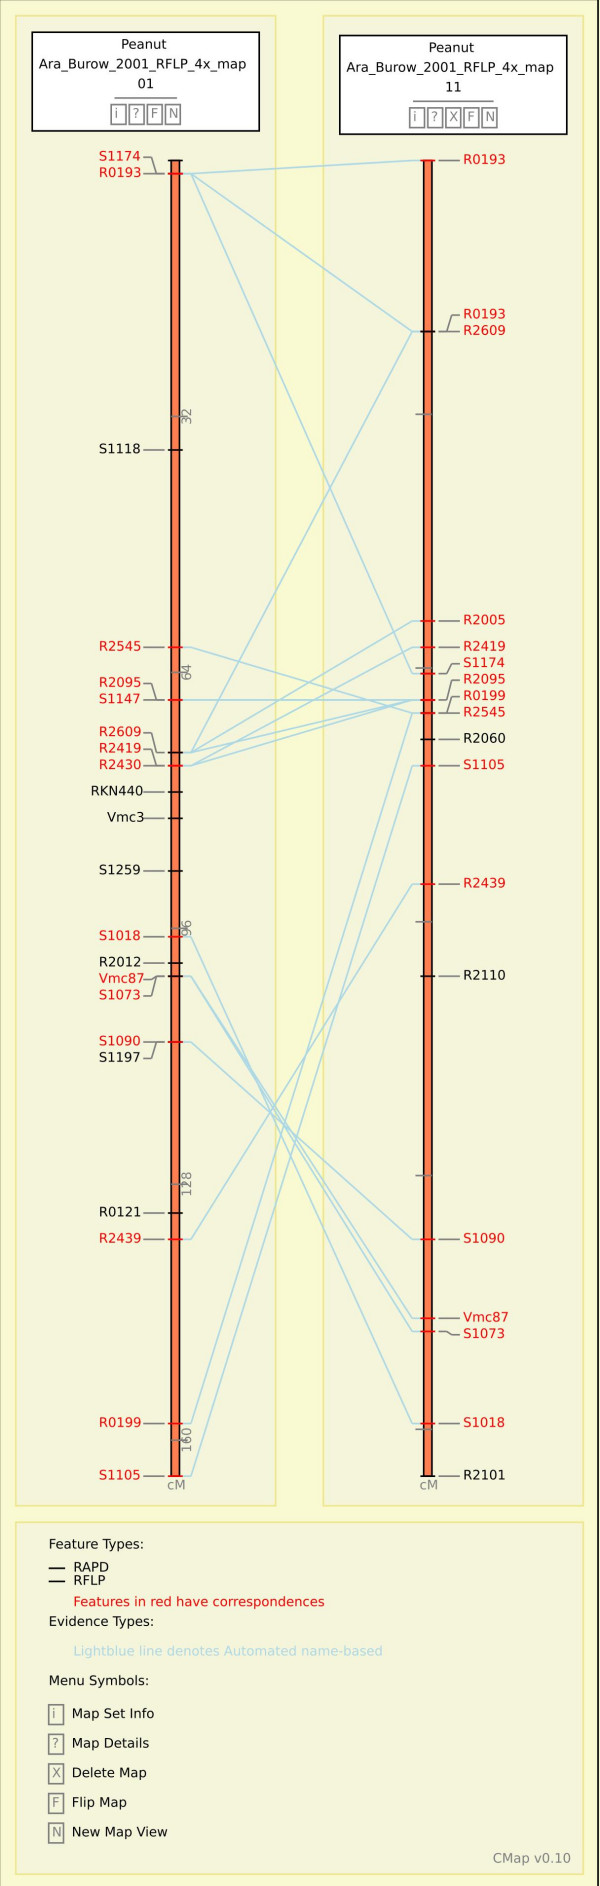
Comparison of homoeologous linkage groups in the same map set. Linkage groups 1 and 11 from the tetraploid map are shown; associated menus are not shown. Lines connect corresponding markers in the two maps.